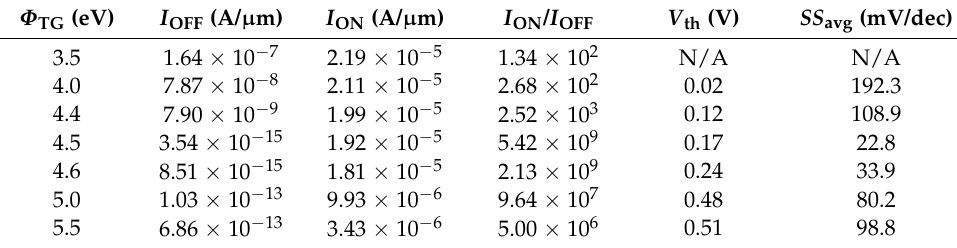
Figure 9. ( a ) Energy band profiles along C–C’ in the OFF-state; ( b ) energy band profiles along A–A’ and B–B’ in the OFF-state; and ( c ) energy band profiles along C–C’ in the ON-state, for DGNP- EHBTFET with Φ TG = 3.5~5.5 eV. Table 3. Extracted parameters from transfer characteristic curves at Φ TG = 3.5 ~ 5.5 eV.